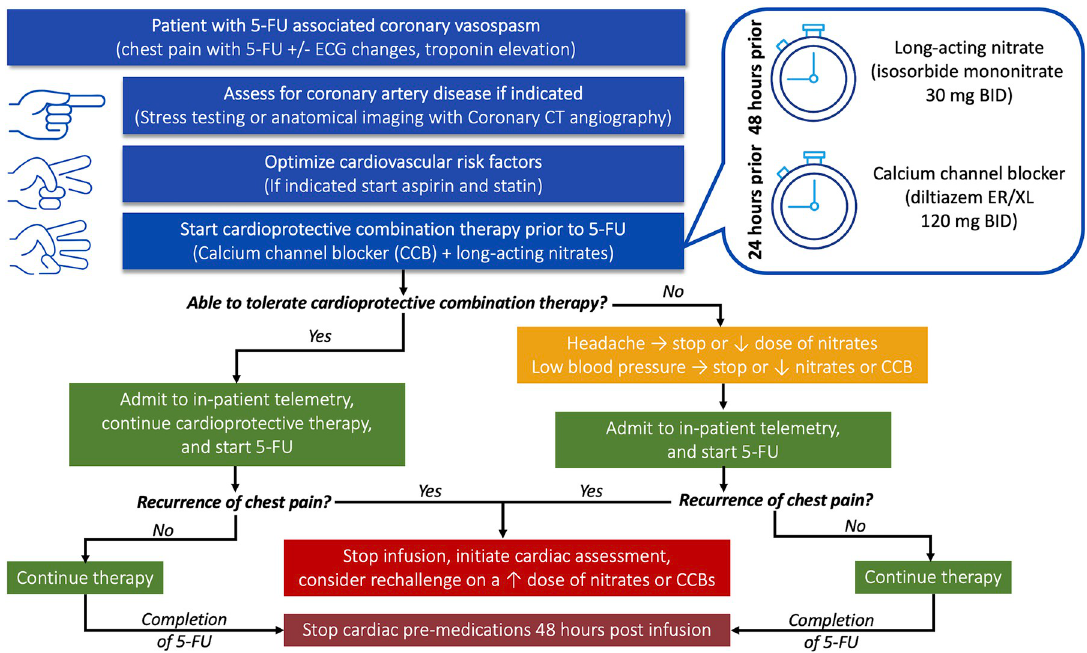
Fig 1. Proposed treatment algorithm for 5-FU (Fluorouracil) coronary vasospasm patients. Suggested treatment algorithm followed by cardio-oncology specialists at our institution.